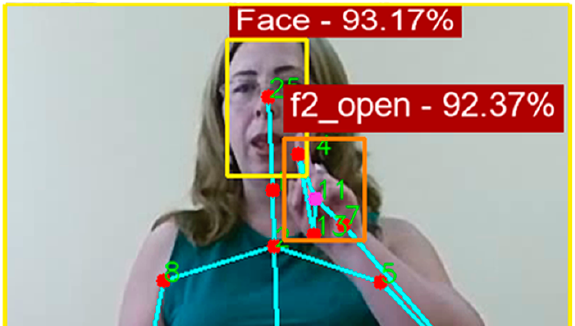
Figure 5. An example of face detecting area and hand-shaped area